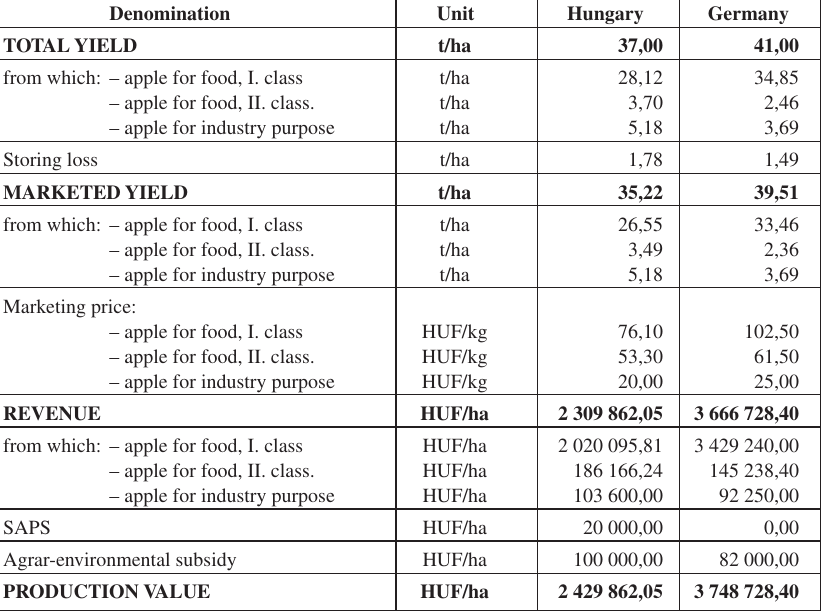
Table 3. The Production Value and its Parameters in the Productive